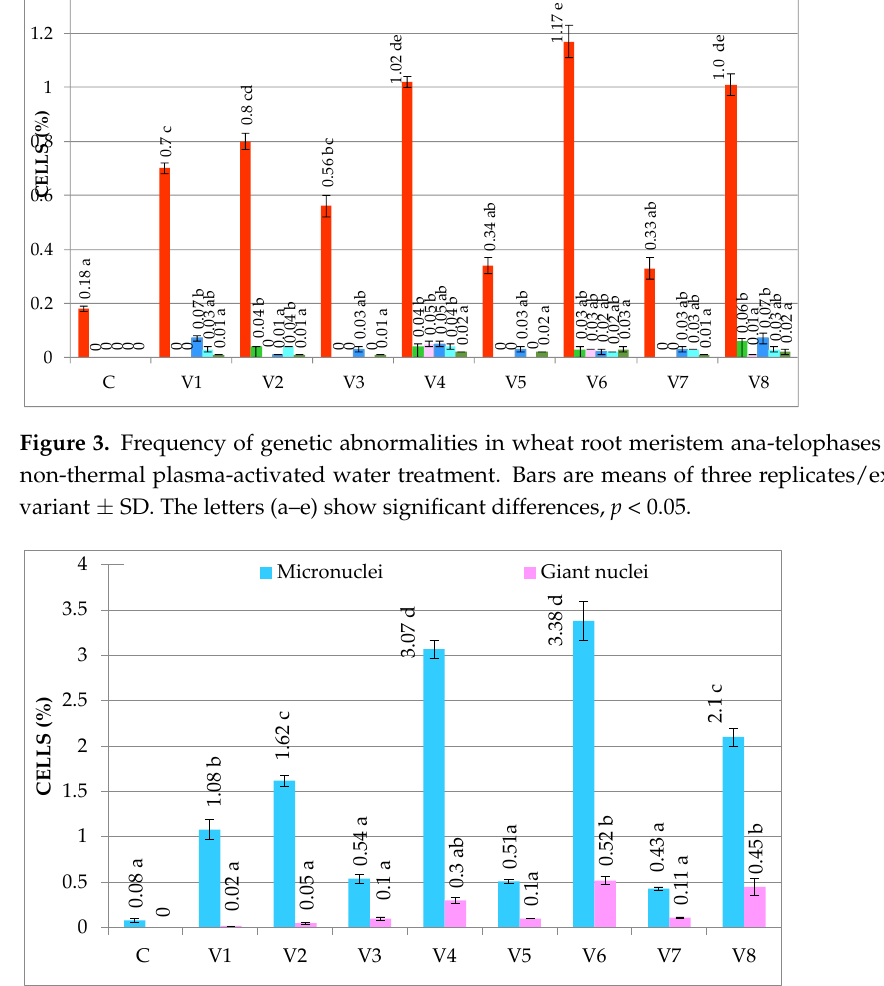
Figure 4. Frequency of genetic abnormalities in wheat root meristem interphases induced by non-thermal plasma-activated water treatment. Bars are means of three replicates/experimental variant ± SD. The letters (a–d) show significant differences, p < 0.05. The correlation between the GI (%) and MI (%) is negative and high (R 2 = − 0.907) (Figure 5).